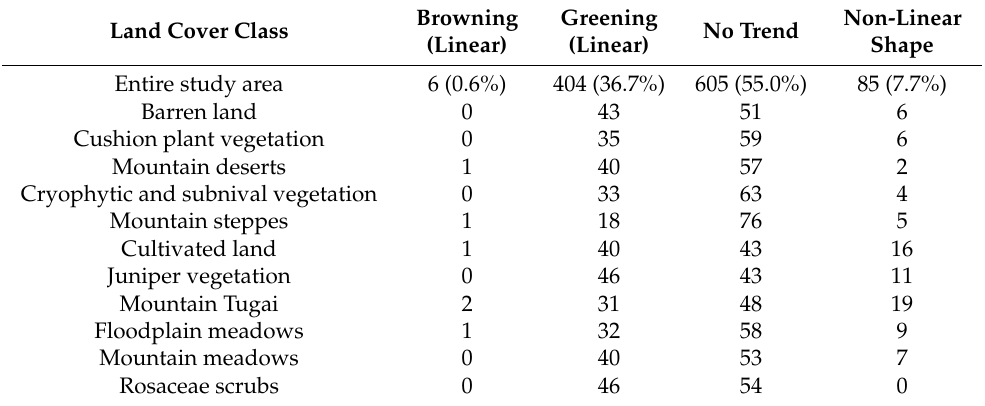
Table 2. Trend type according to land cover class, based on 1100 test plots (100 per land cover